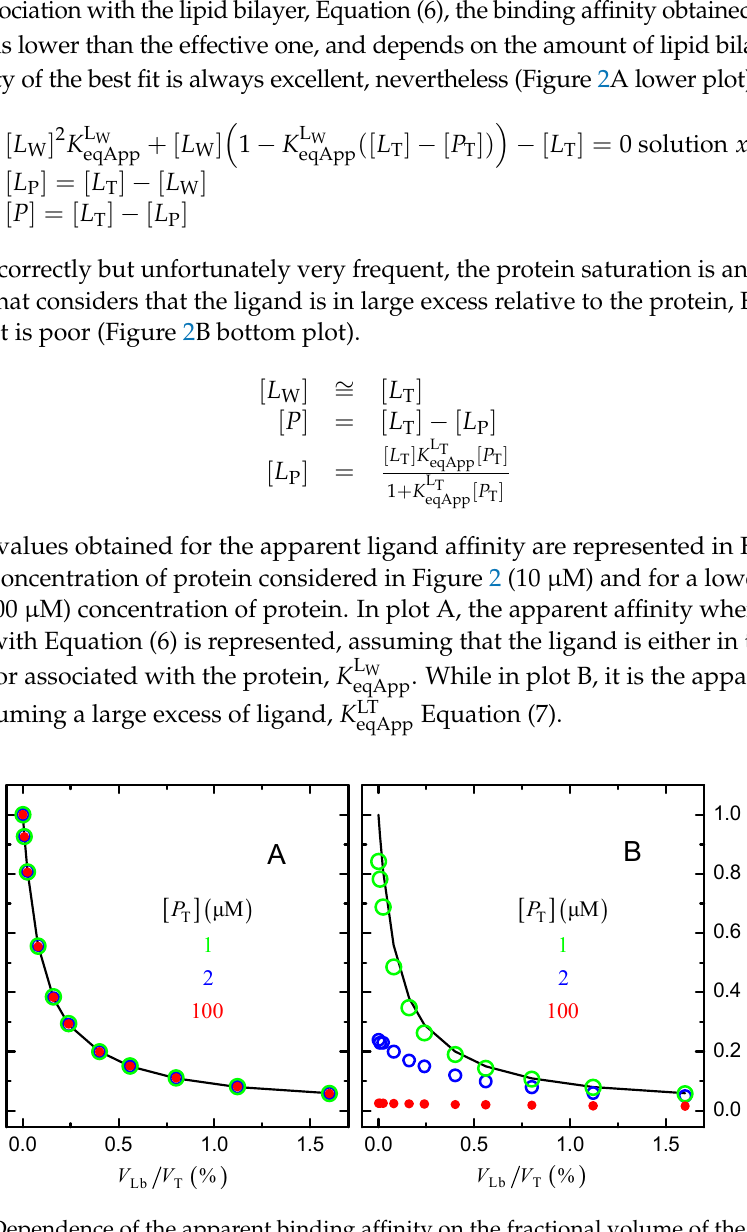
K Equation (7), Equation (7), eqApp eqApp = 10 3 , for L K = 10 3 , for PLb P Lb